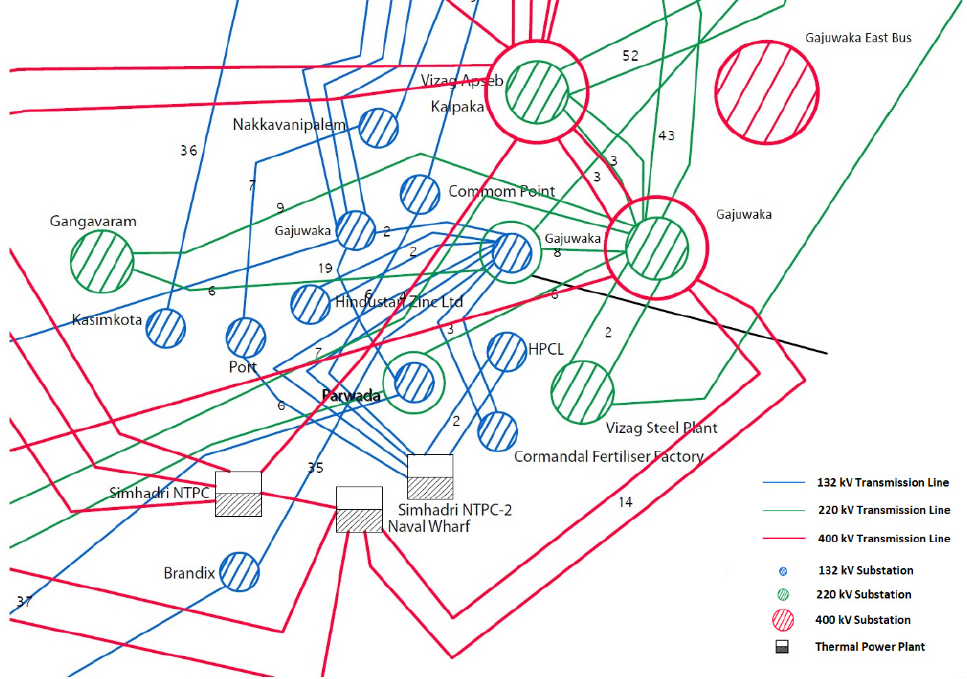
Figure 6. Access to grid in the proposed site.